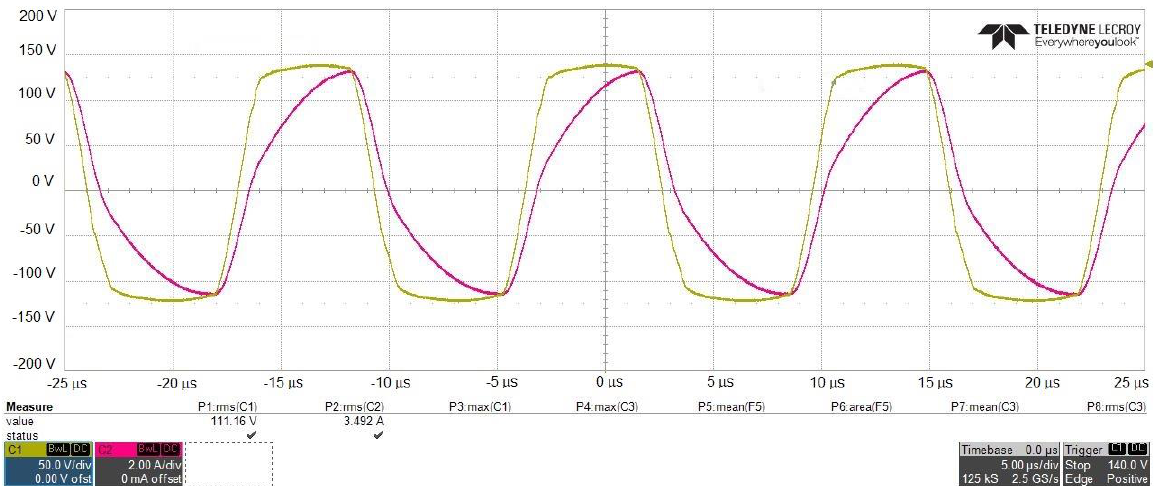
Figure 27. Transmitter coil voltage (C4, green) and current (C3, blue) at 26 kHz. The voltage and current waveforms of the receiver coil are given in Figures 28–31 for different switching frequencies. Here, the current has an inductive characteristic as it is in the transmitter coil.